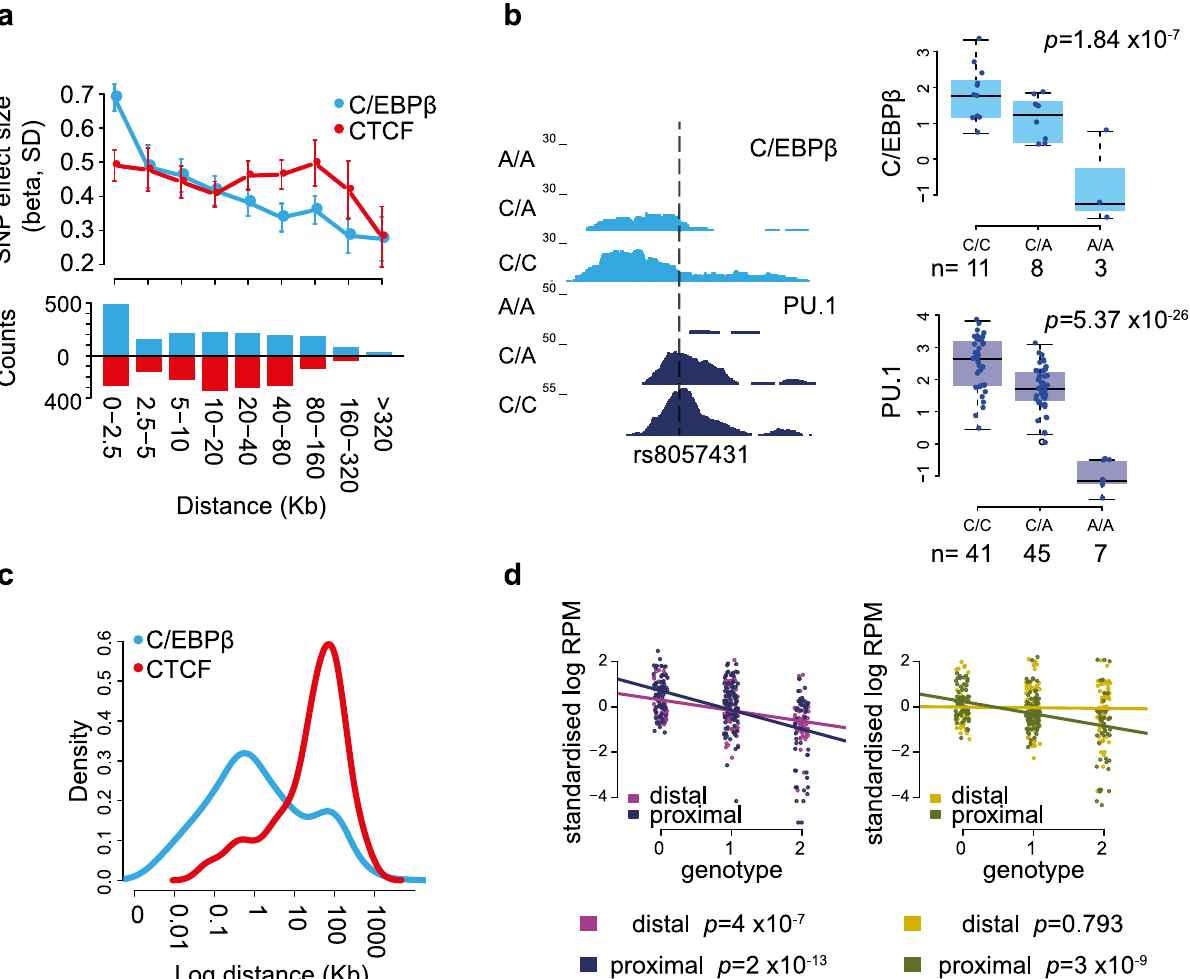
Fig. 2 Effect of PU.1 SNPs on second transcription factor binding. a Mean effect size (95% con fi dence intervals) for association of proximal sentinel PU.1 SNPs with the nearest C/EBP β (light blue) and CTCF (red) binding site. The effect size decreases with distance for C/EBP β (linear model p < 2.2 × 10 − 16 ) but not for CTCF (linear model p = 0.113). Beneath: bar chart of number of peaks included in each distance bin. b Genome browser shot of an illustrative example of tfQTL, where SNP rs8057431 (dashed line) alters a PU.1 motif and is associated with a disruption in binding of both PU.1 and C/EBP β . With signal box plots created from all individuals segregated by genotype. Box plots show the medians (centre lines) and the 25th and 75th percentiles (box edges), with whiskers extending to 1.5 times the interquartile range. p values were obtained by fi tting linear mixed models implemented in LIMIX. n = the number of independent donors. c Density plot displaying distance of lead proximal PU.1 SNP to the nearest shared association ( p < 10 − 5 ) C/EBP β (light blue) or CTCF (red). d Transcription factor binding intensity for PU.1 ( y axis Log RPMs) at shared PU.1 and C/EBP β tfQTL from fi ve matched individuals in two cell types Neutrophils (left panel) and Monocytes (right panel). Binding sites were segregated by donor genotype ( x -axis). tfQTL are categorised as either proximal or distal (33 distal and 43 proximal) and linear models were fi tted separately for proximal and distal